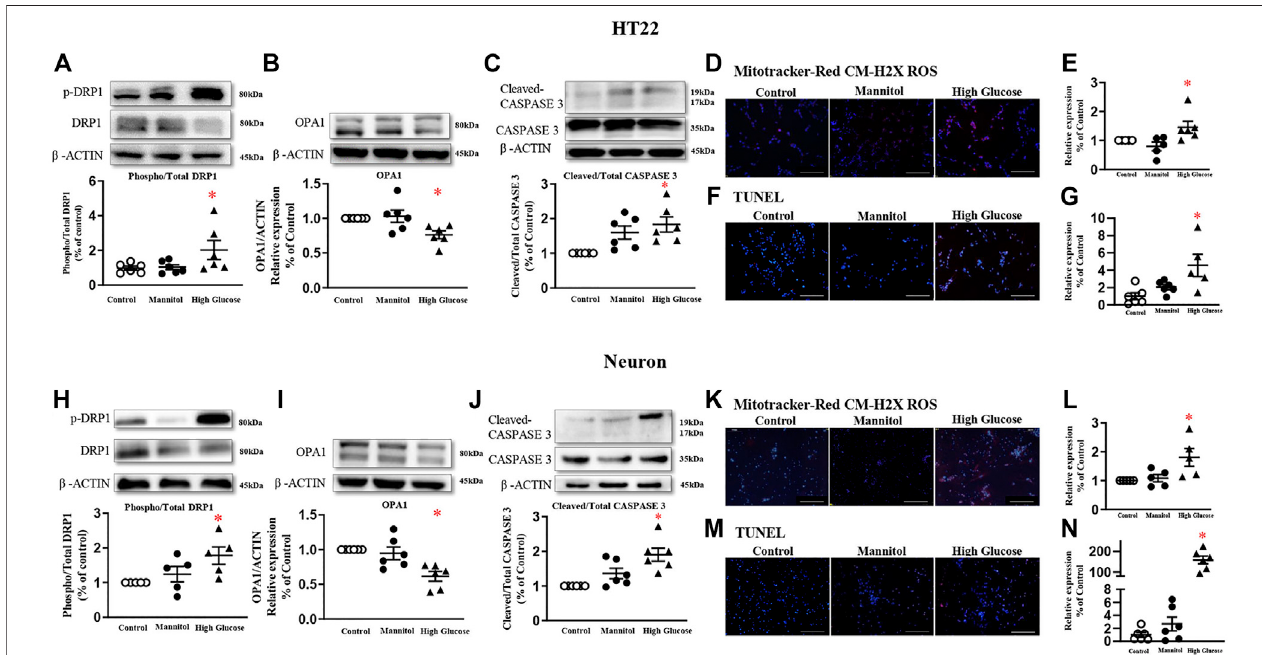
FIGURE 2 | High glucose increases mitochondrial fi ssion in neurons and induces neuron apoptosis in HT22 (A-G, upper panel) and neurons (H-N, lower panel). Representativeblotsanddensitometricquanti fi cationofDRP1,OPA1,andcaspaseproteinsinHT22 (A – C) andneurons (H – J) .ThephosphorylationofDRP1(topblots) wasnormalized tototalDRP1 protein (middle), and total DRP1wasnormalized to β -ACTIN (bottom).Fluorescent signals and quanti fi cation ofMitotracker-Red CM-H2X ROS in HT22 (D – E) and primary neurons (K – L) stimulated with high glucose. (200 ×, Bar = 800 µm). Hoechst labeled the nuclei (blue), and Mitotracker-Red CM- H2XROSwasstainedinred(Fluor594).Fluorescentsignalsandquanti fi cationofTUNELinHT22 (F – G) andprimaryneurons (M – N) stimulatedwithhighglucose.(200×, Bar = 800 µm). DAPI labeled the nuclei (blue), and TUNEL was stained in red (Fluor 594). Data presented as means ± SEM, * p < 0.05 vs cells under control condition by One-way